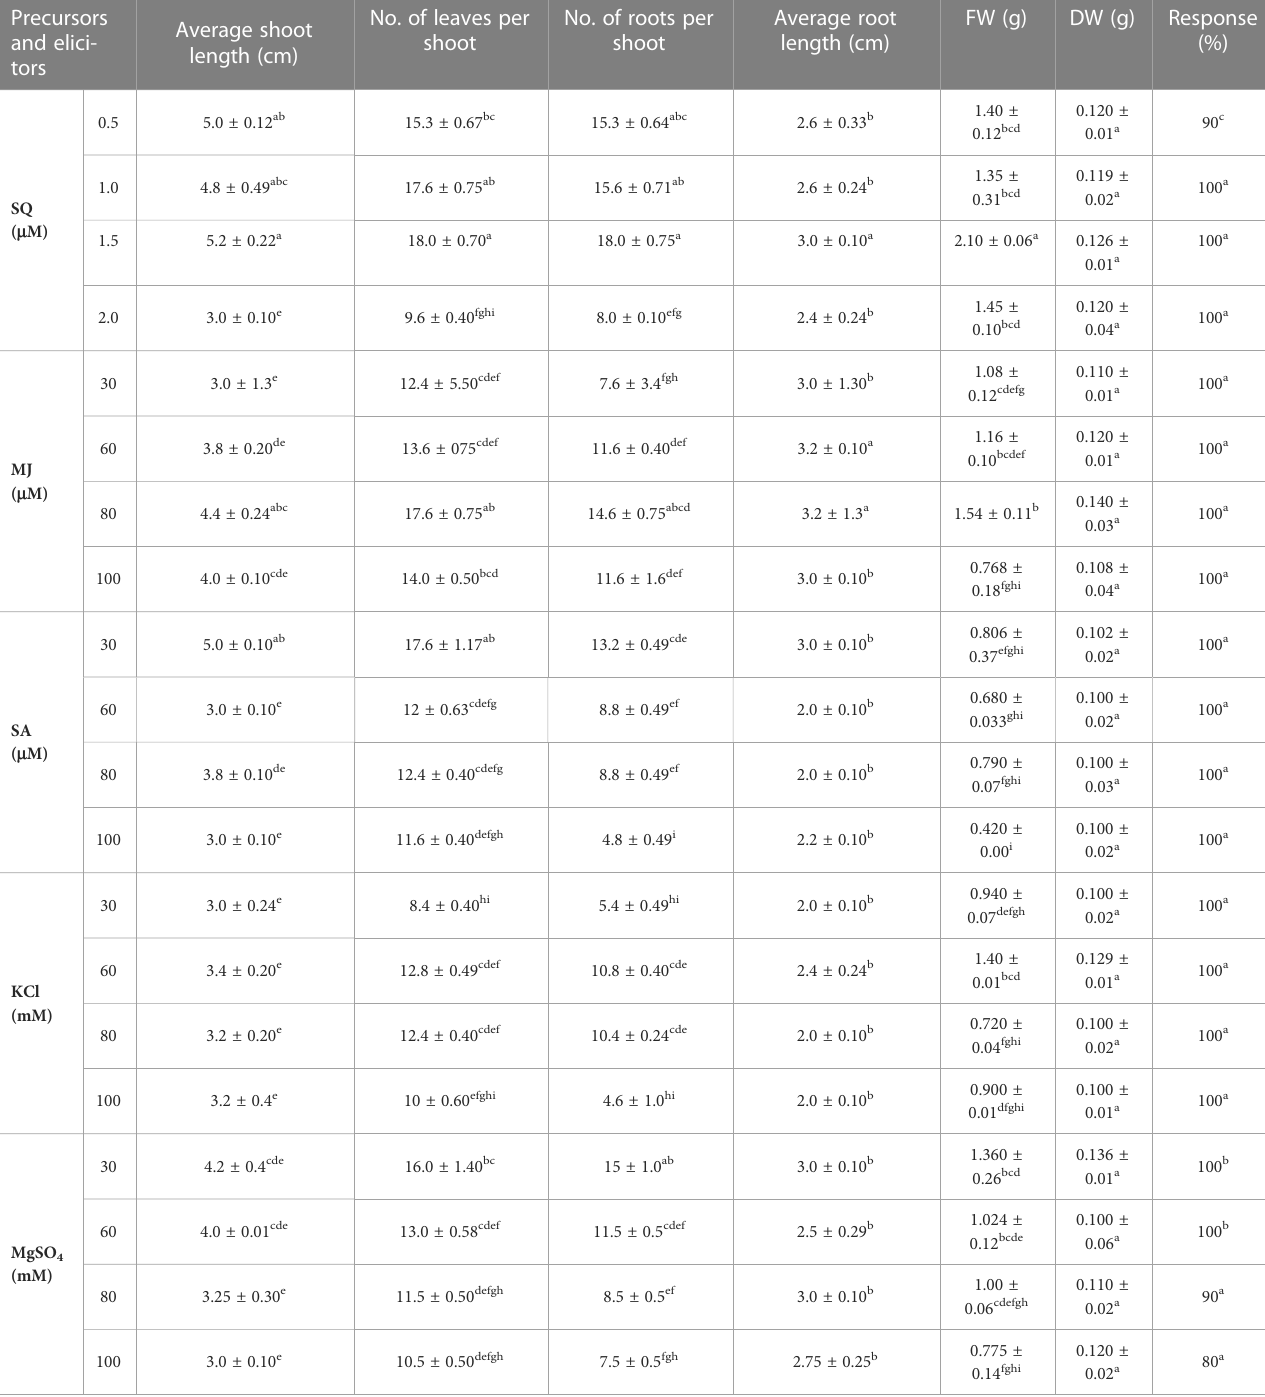
TABLE 3 Effect of precursor (squalene) and elicitors (methyl jasmonate, salicylic acid, potassium chloride, and magnesium sulfate) on regeneration of Bacopa fl oribunda . Precursors and